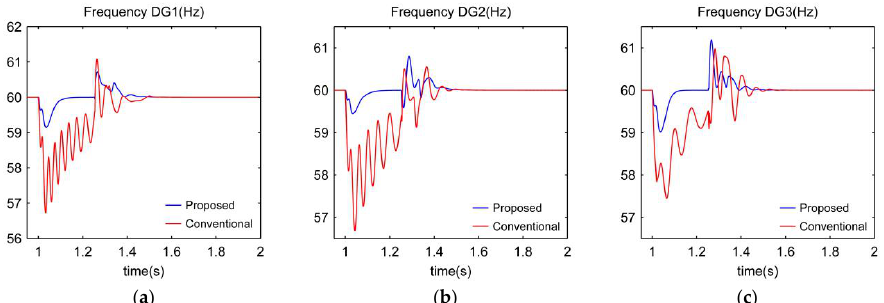
Figure 19. Frequency response of DG’s in short circuit condition using proposed supplementary control compare with conventional droop controller ( a ) DG1; ( b ) DG2; and ( c ) DG3.